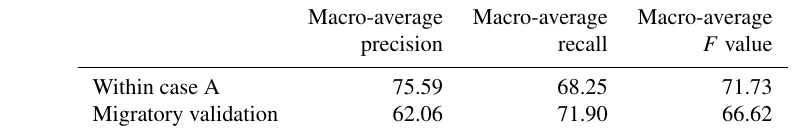
Table 4. Comparison of the macro-average indicators in two situations (unit %).